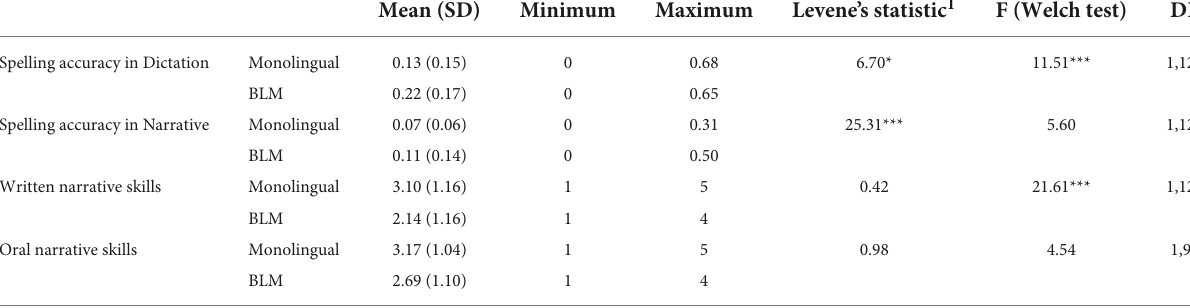
TABLE 1 Descriptive analyses and one-way ANOVA and ANOVA with robust methods